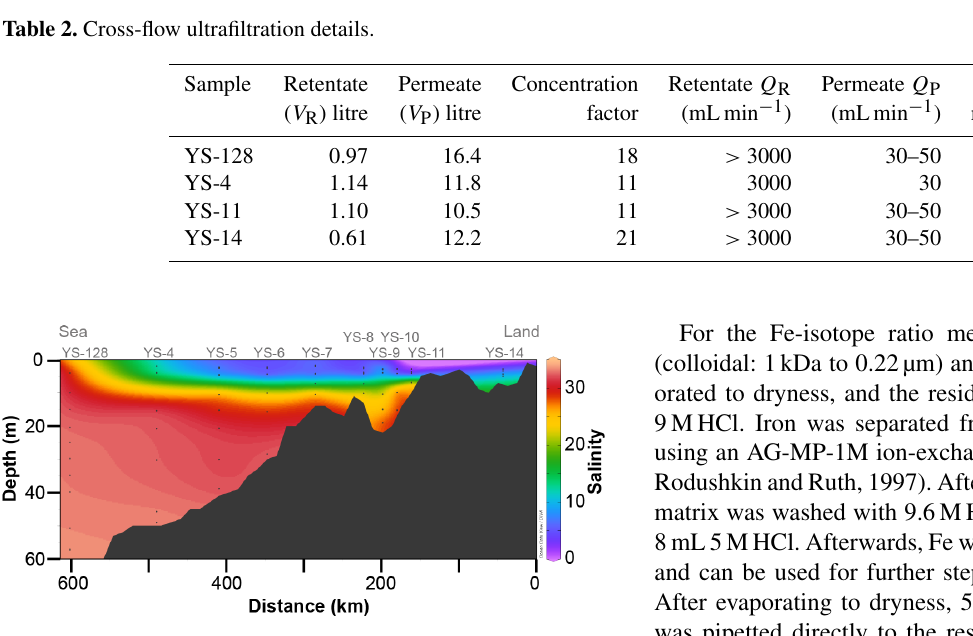
Figure 2. The salinity gradient along the Lena River–Laptev Sea transect. Salinity is based on the Practical Salinity Scale PSS-78. The freshwater builds an almost 10m thick surface layer in the Laptev Sea, and the plume itself extends over an area of about 50 × 600km. The plume is divided into an inner and outer plume between stations YS-8 and YS-11 by a sharp increase in